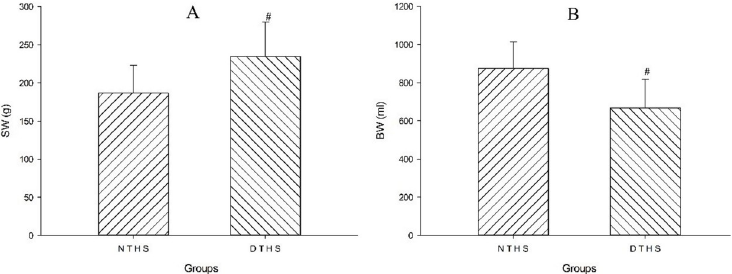
Fig 4. Comparison of volume of blood withdrawn and weight of spleen between NTHS and DTHS groups. A, weight of spleen; B, volume of blood withdrawn in two groups; BW, volume of blood withdrawn; SW, weight of spleen. Values are shown as mean ± SEM. P < 0.05 was considered statistically